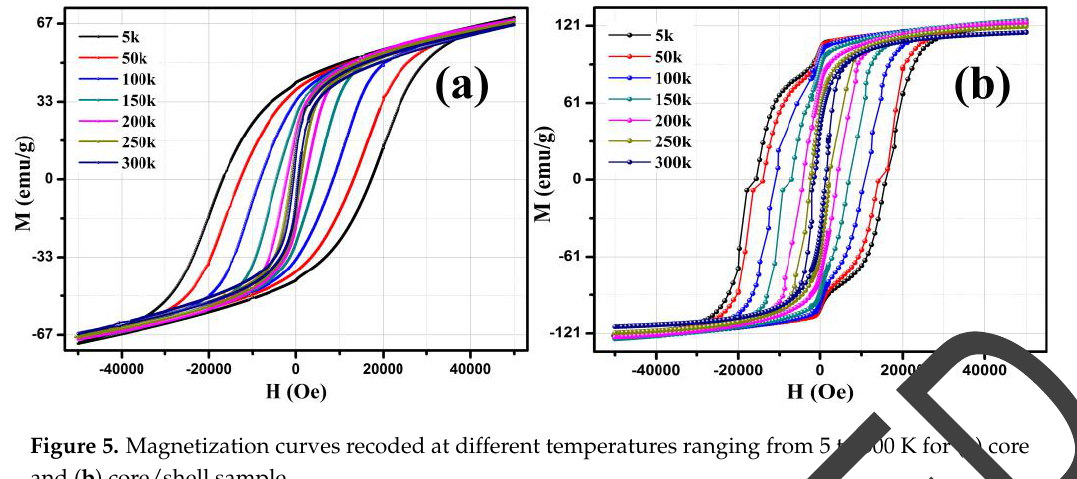
Figure 5. Magnetization curves recoded at different temperatures ranging from 5 to 300 K for ( a ) core and ( b ) core/shell sample. Nanomaterials 2016 , 6 , 72